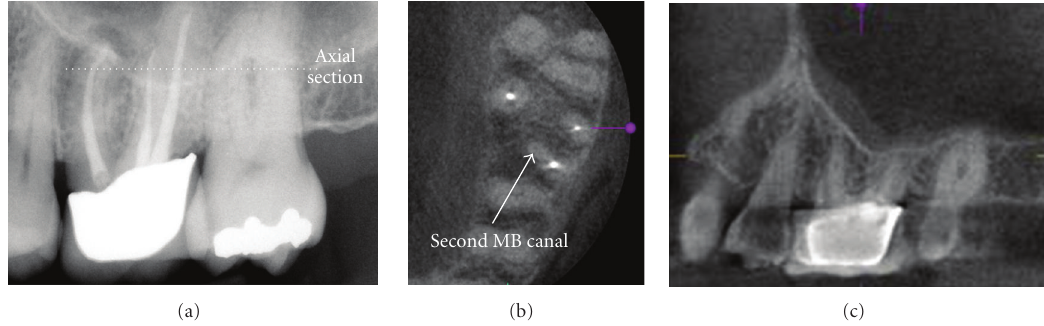
Figure 7: Maxillary first and second molars often present treatment challenges because of the frequent presence of mesioaccessory (mb2) canals. On initial periapical radiographic examination of this previously treated maxillary left first molar, no mb2 canal was detected; however a periapical lesion is seen (a). Note the overlap of the interproximal contacts between the molars indicating a geometric distortion in the horizontal plane. CBCT imaging ((b) 0.076 mm axial and (c) 0.076 parasagittal) clearly demonstrates an additional canal that was not previously